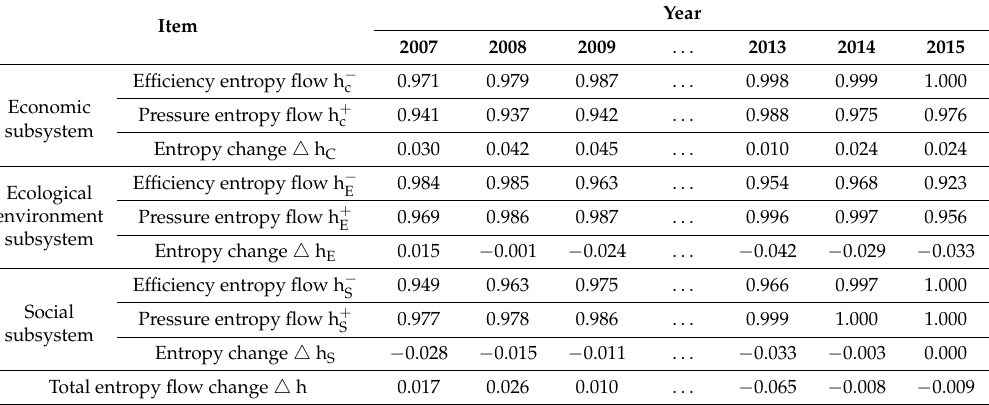
Table 4. System entropy flow change.